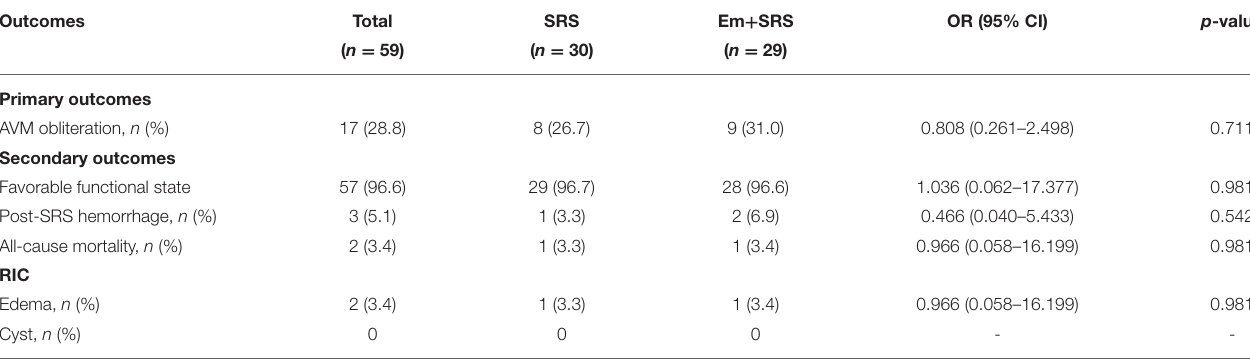
TABLE 4 | Primary and secondary outcomes of unruptured